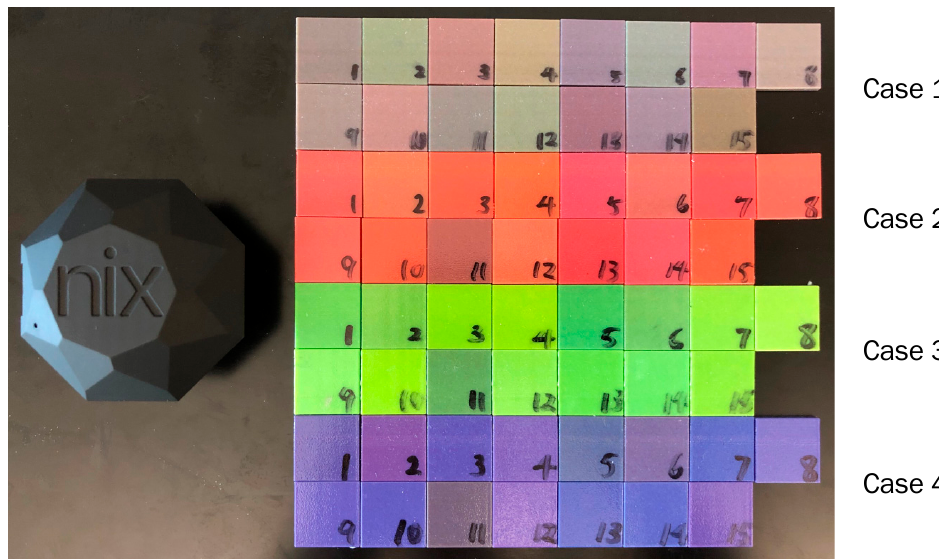
Figure 3. The Nix Pro colorimeter and printed samples for four cases.